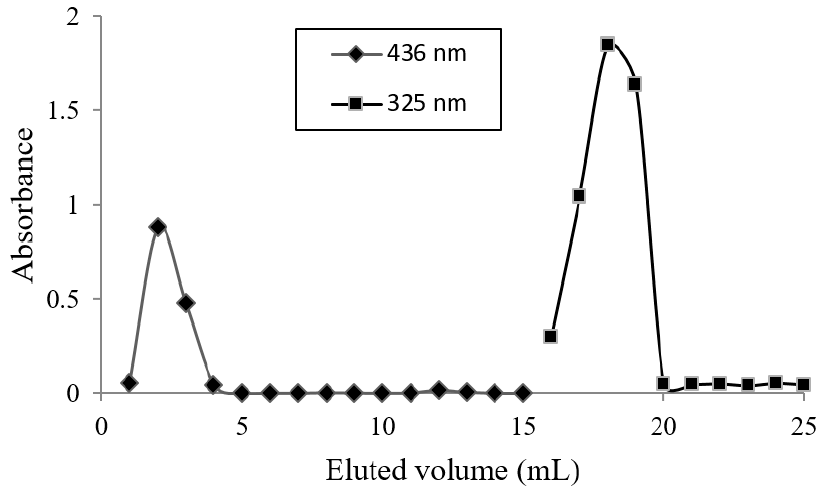
Figure 6. Elution profile of ε Vin-loaded MLL aqueous suspension. Volume of each fraction—1 mL. Fractions 1 to 8 were eluted with water, and the others with methanol.